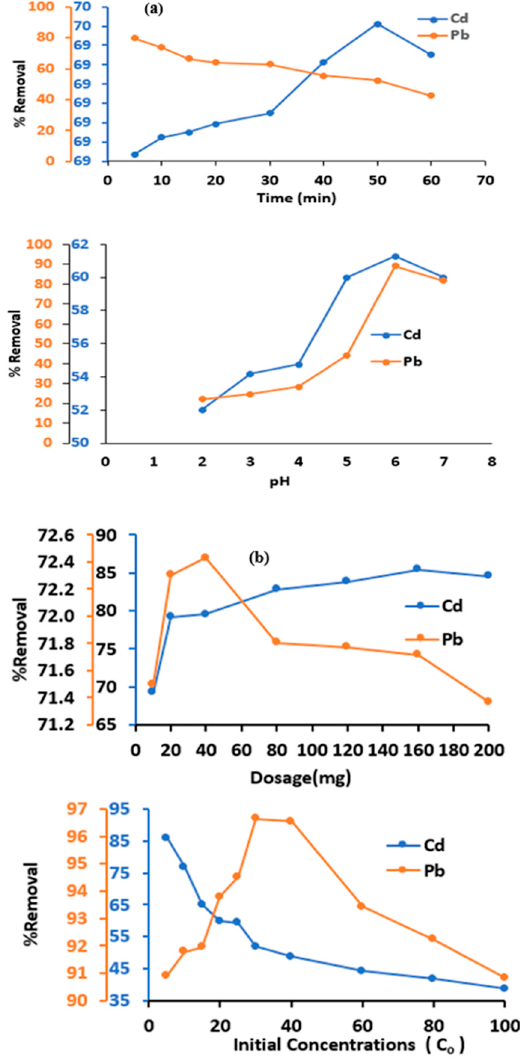
Figure 6. ( a ) The influence of contact duration and pH on the elimination of cadmium and lead ions. ( b ) Effect of adsorbent dosage and initial metal ion concentration on the elimination of Cd 2+ and Pb 2+ ions.